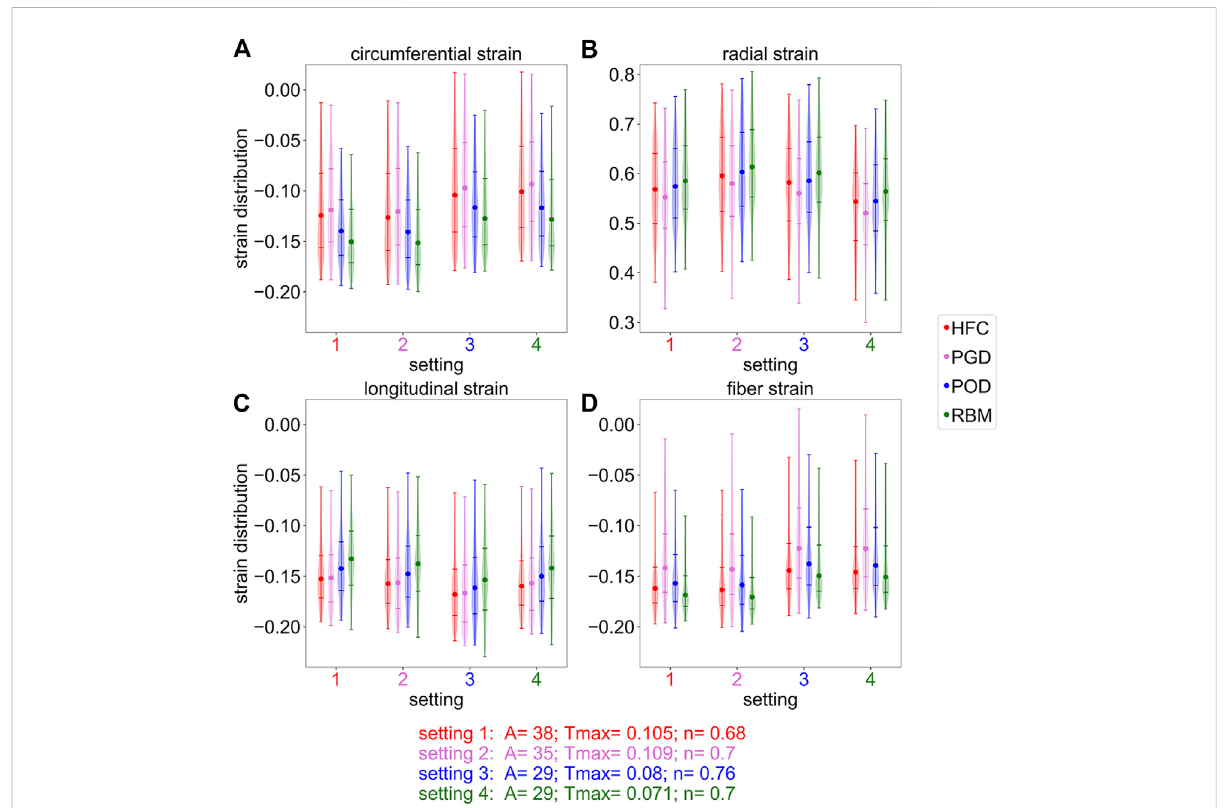
FIGURE 7 Distribution of the simulated strains in systole, cropped at the 5th and 95th percentiles. The subplots correspond to the circumferential (A) , radial (B) , longitudinal (C) , and fi ber (D) strain at the end-systolic time-point assigned to the peak radial strain. Each subplot shows four strain distributions (one for each interpolated fi ber fi eld) for four different parameter settings (labeled on the x -axis), respectively. The parameter settings are obtained by optimization with one interpolated fi ber fi eld: 1) HFC, 2) PGD, 3) POG, 4) RBM. Round markers indicate the median, horizontal lines indicate the fi fth,25th,75th, and 95th